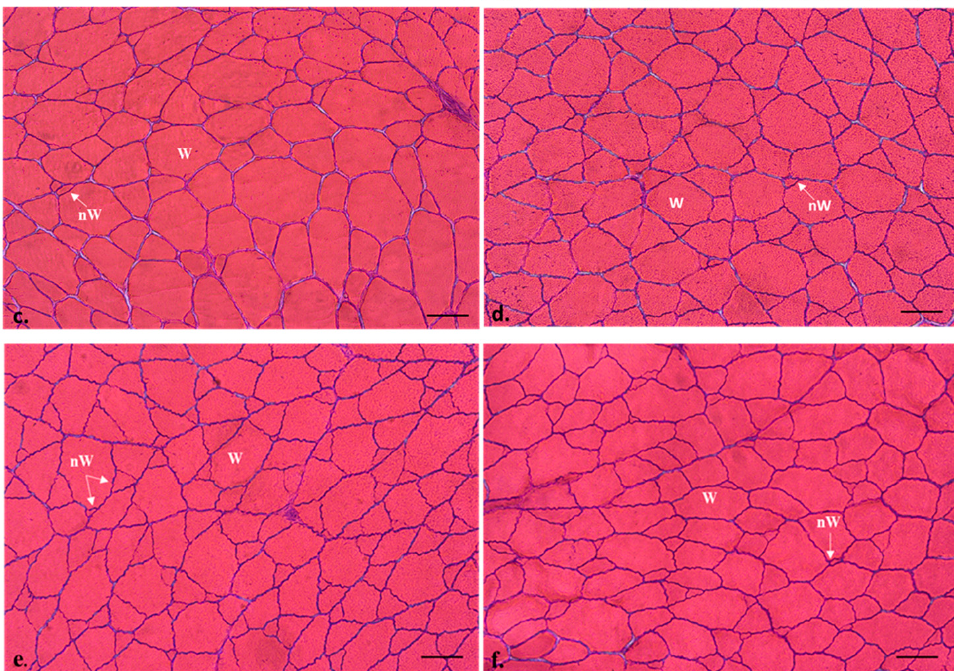
Figure 1. Transverse sections of the white muscle of commercial-size gilthead sea bream (1.6-year-old adult specimens), from C ( a ), R2.5 ( b , c ), H2.5 ( d ), and H5 ( e , f ) groups. Hematoxylin-Eosin staining. W: white muscle fibres; nW: new white muscle fibres. The white muscle fibres density was higher in the H2.5 and H5 groups ( d – f ) than in the other groups ( a – c ). Bars 100 µ m. R2.5 versus H2.5 groups: when comparing the muscle parameters of the adult speci- mens previously fed with raw versus hydrolyzed diets at the same concentration (2.5%), the hydrolyzed diets increased the values of the transverse area of the white muscle (Table 3). Regarding the muscle cellularity, the raw diets increased the size of the fibres (hypertrophy values: area and minor axis length of the white muscle fibers) ( p < 0.05) (Table 3, Figure 2a), whereas the hydrolyzed diets increased the hyperplasia values (white muscle fibres num- ber) ( p < 0.05) (Figure 2b) and the fibrillar density (number of white fibres mm − 2 ) (Table 3;